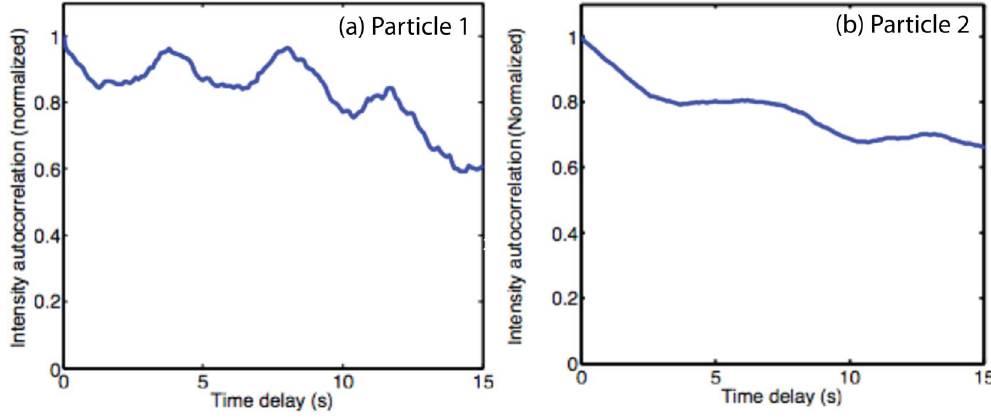
Figure 7. Intensity autocorrelogram for ( a ) particle 1, and ( b ) particle 2. Comparing rotational ( a ) and translational ( b )